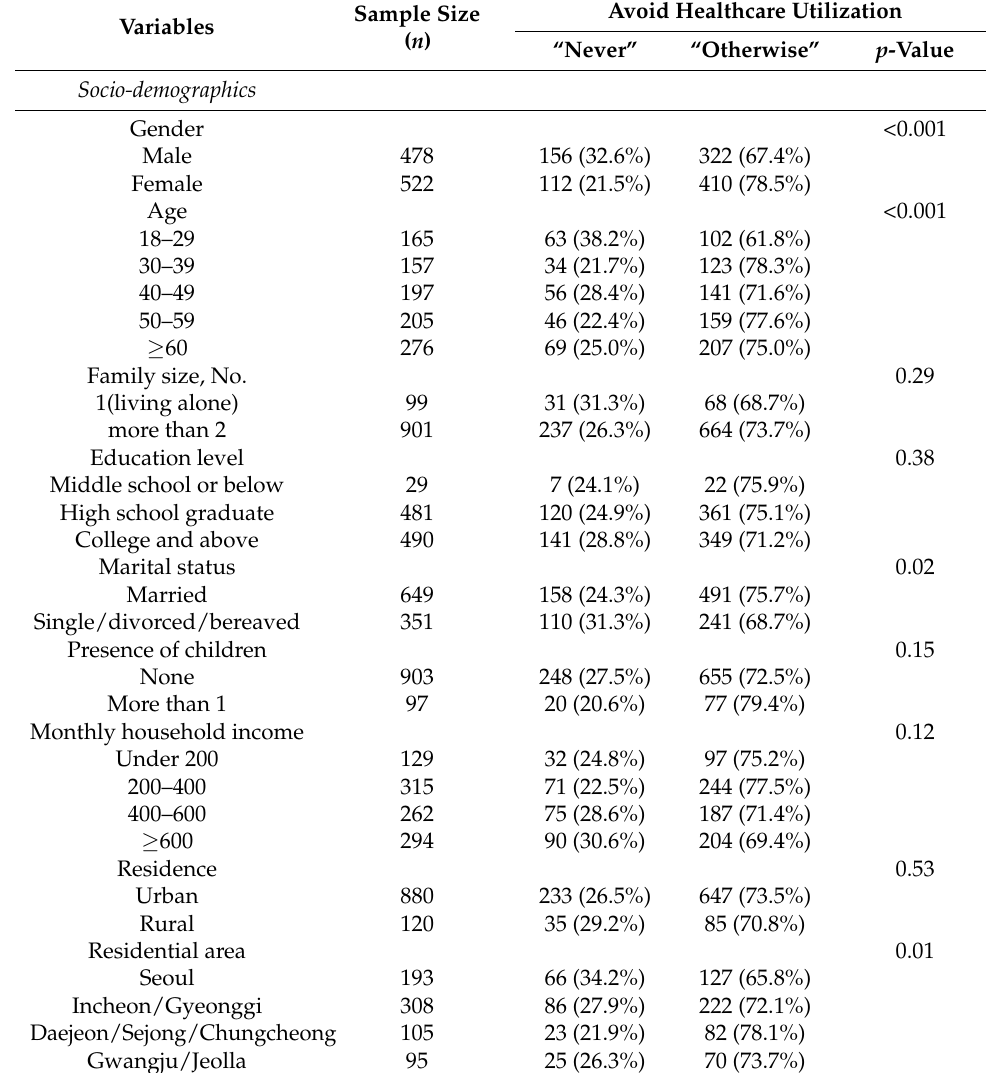
Table 2. Chi-square statistics for variables related to healthcare utilization